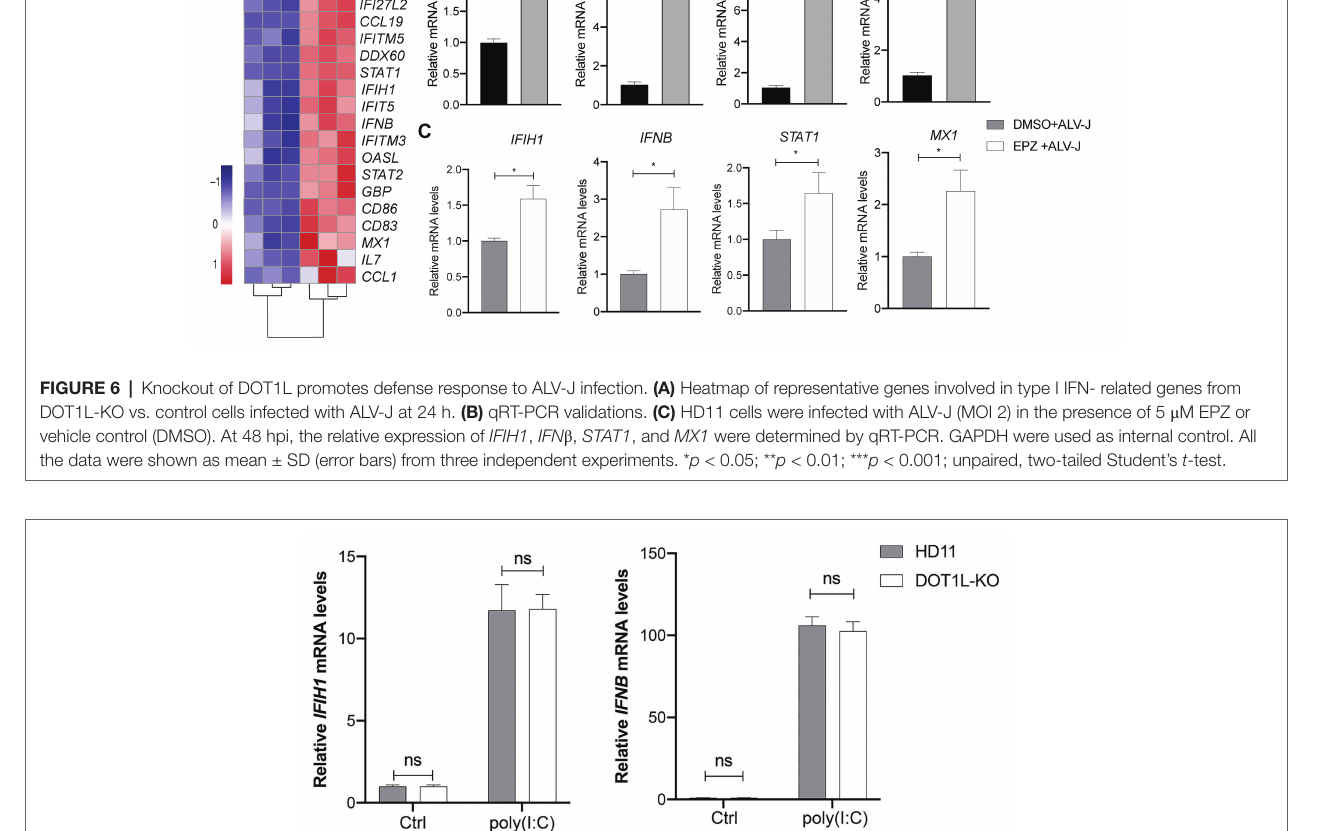
FIGURE 7 | Disruptor of telomeric silencing 1-like does not directly regulate the melanoma differentiation-associated protein 5 (MDA5)-mediated IFN β signaling. HD11 and DOT1L-KO cells were transfected with nothing (Ctrl) or 2 μ M poly(I:C) for 8 h. The relative IFIH1 and IFN β mRNA levels were measured by qRT-PCR and normalized to GAPDH. All the data were shown as mean ± SD (error bars) from three independent experiments. ns, not significant; unpaired, two-tailed Student’s t -test.